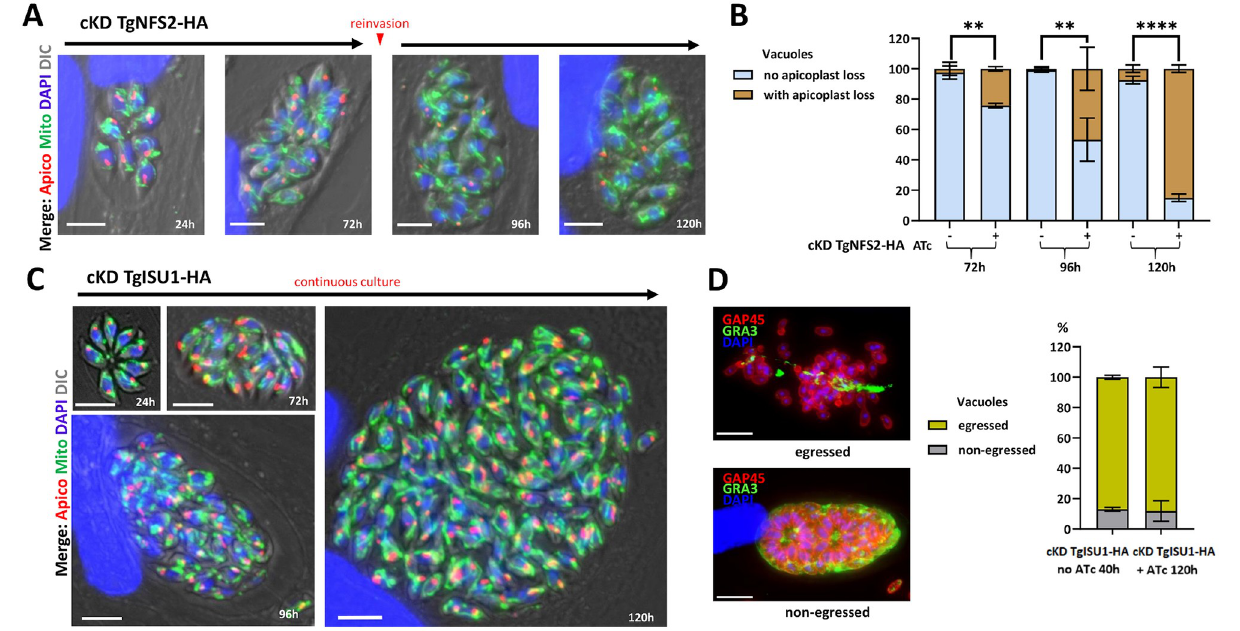
Fig 5. Impact of TgNFS2 and TgISU1 depletion on intracellular tachyzoites. A) Depletion of TgNFS2 impacts the apicoplast. cKD TgNFS2-HA parasites were kept in the presence of ATc and the aspect of the apicoplast and mitochondrion was evaluated by microscopic observation using specific markers (CPN60 and F1 β ATPase, respectively). After 72 hours, parasites egressed and were used to reinvade new host cells for subsequent timepoints. Scale bar represents 5 μ m. DNA was labelled with DAPI. DIC: differential interference contrast. B) Quantification of apicoplast loss in vacuoles containing cKD TgNFS2-HA parasites after 72 to 120 hours of incubation with ATc. Data are mean values from n = 3 independent experiments ± SEM. �� p � 0.01, ���� p � 0.0001, Student’s t -test. C) Depletion of TgISU1 does not impact mitochondrial and overall parasite morphologies, but affects parasite growth. cKD TgISU1-HA parasites were grown in the presence of ATc for up to five days and the aspect of the apicoplast and mitochondrion was evaluated by microscopic observation using specific markers described in A). Growth in the presence of ATc was continuous for up to five days. Scale bar represents 5 μ m. DNA was labelled with DAPI. DIC: differential interference contrast. D) Egress is not affected by TgISU1depletion. An egress assay was performed using calcium ionophore A23187. On the left are representative images of vacuoles containing parasites that egressed normally or did not. GRA3 (parasitophorous vacuole marker) staining is shown in green and GAP45 (parasite periphery marker) in red. Scale bars = 10 μ m. On the right is the quantification of egress for cKD TgISU1-HA parasites kept in the presence of ATc or not. Mean values ± SEM from n = 3 independent biological experiments are